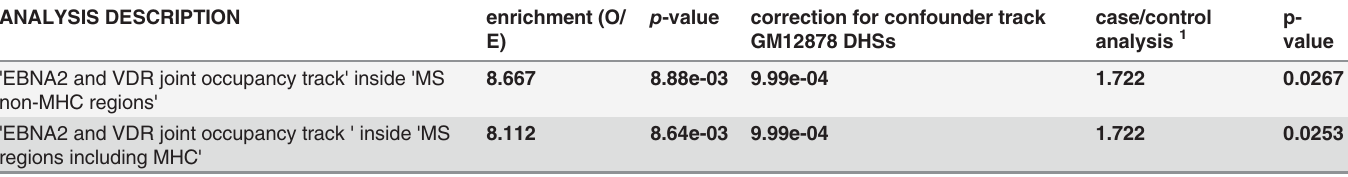
trary, RA and SLE regions showed results comparable to those seen in MS (O/E for RA, MHC included = 4.776-fold, p = 9.99e-05; O/E for SLE, MHC included = 6.4-fold, p = 9.99e-05) (Table 3); analyses performed without considering MHC regions yielded similar results (data not shown). We then performed case-control enrichment analyses using MS regions with MHC as cases and obesity, UC, RA and SLE as controls. We observed an excess enrichment of EBNA2